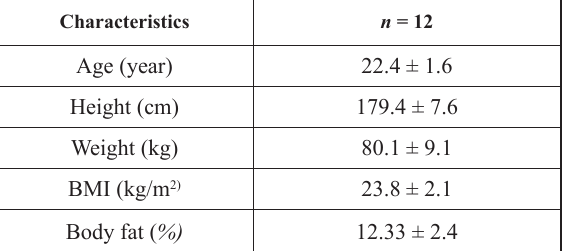
Table 1. Physical characteristics of the participants